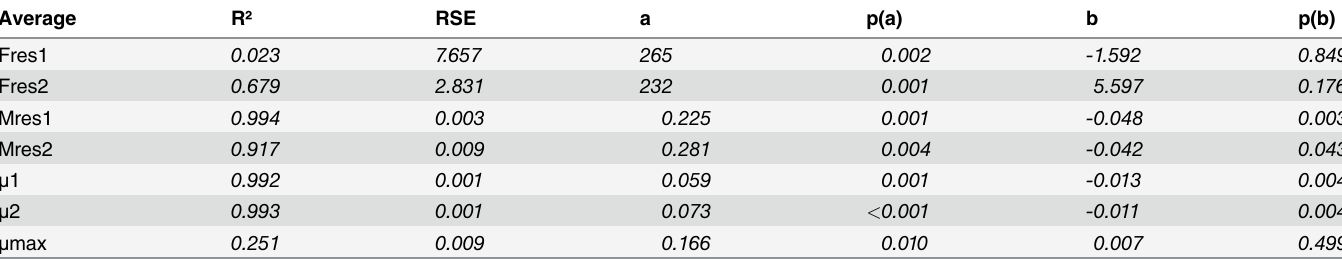
Table 5. Average postoperative trends of the contact force (F res ), friction moment (M res ) and coefficient of friction ( μ ). Average